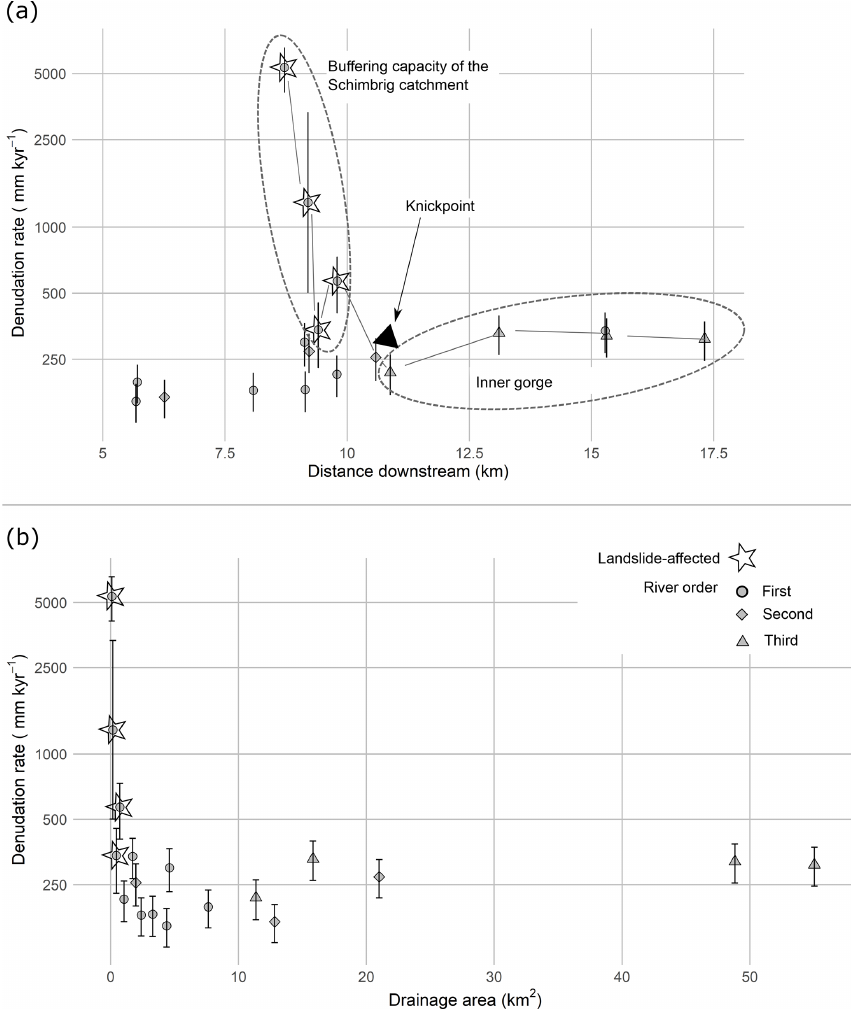
Figure 6. CRN-derived denudation rates (mmkyr − 1 ) in the Entle catchment against (a) downstream distance and (b) drainage area. Down- stream distance is computed from the river source to the outlet of the Entle catchment. Samples from the earthflow-affected Schimbrig catchment are marked with a star. The grey lines connect the points that are hydrologically connected and part of the same fluvial system (Schimbrig, Rossloch, Kleine Entle, and Grosse Entle rivers). Denudation rate values on the y axis are shown on a logarithmic